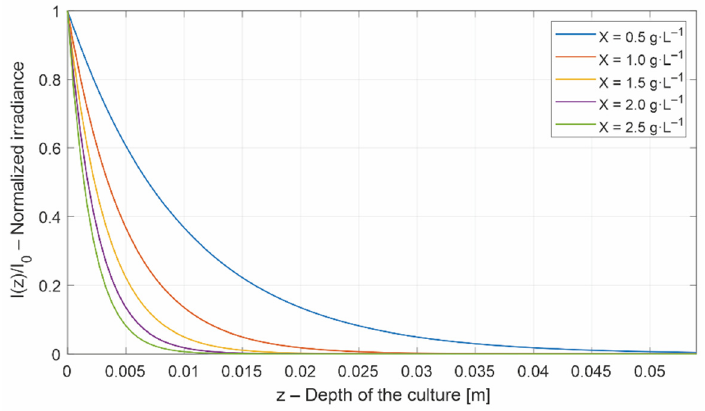
Figure 1. The normalized irradiance attenuation with the depth of the culture, at an incident light intensity of 500 μ mol ∙ m − 2 ∙ s − 1 .